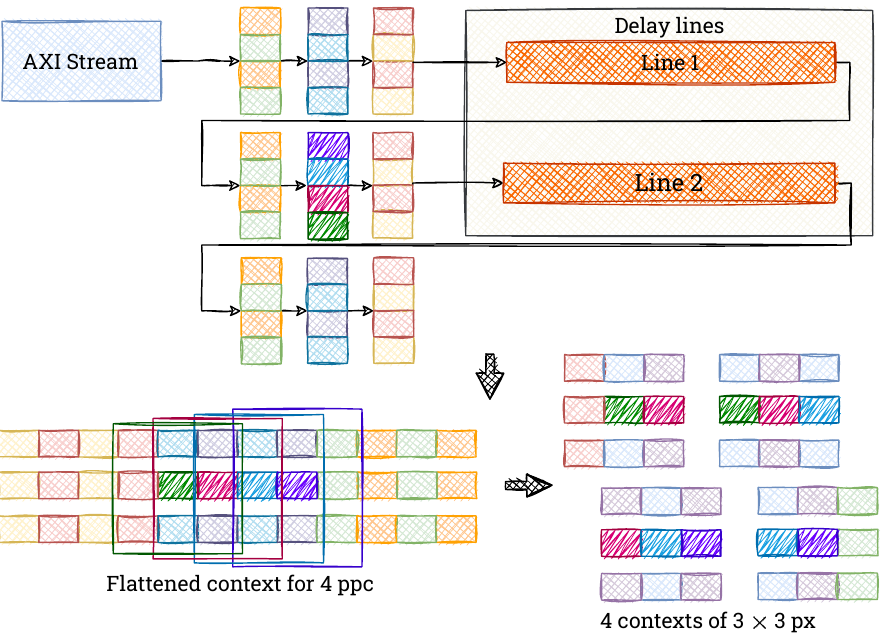
Figure 3. Typical scheme for the generation of contexts 3 × 3 px for 4 ppc vector format. The dark green, pink, blue and purple pixels are the centres of 3 × 3 px contexts.